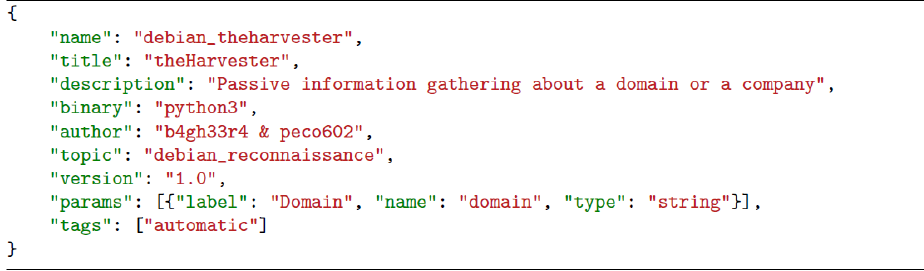
Figure 6. Example of module metadata.